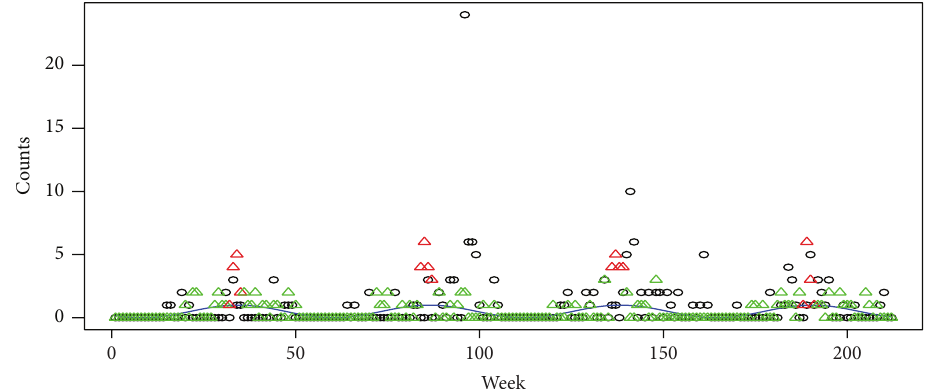
Figure 5: Simulated (triangles) and real (circles) E . coli O157:H7 infection counts, Missouri, Eastern Region, 2010–2013. Simulated outbreaks are the red triangles. The fitted trigonometric model is the blue